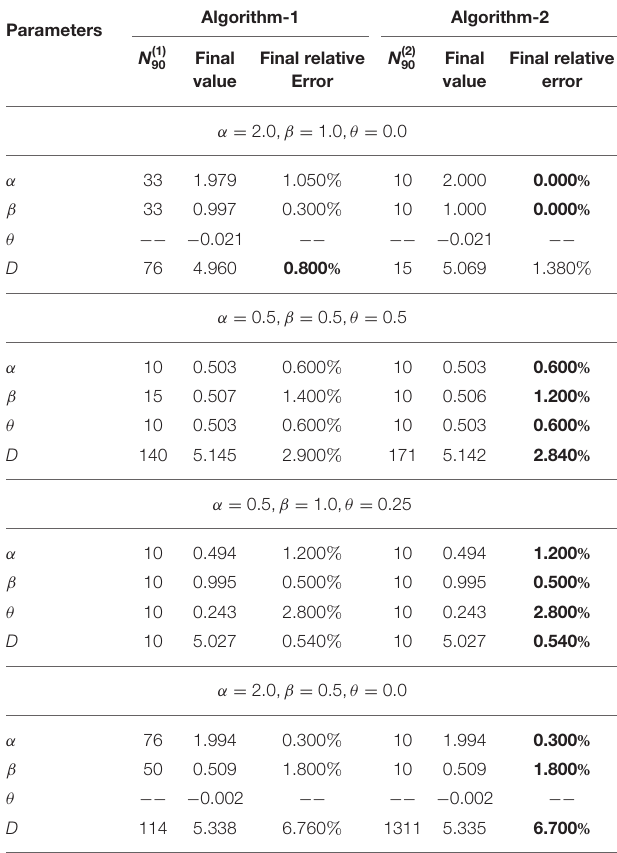
TABLE 3 | Numerical results for fractional diffusion parameter estimation with D =